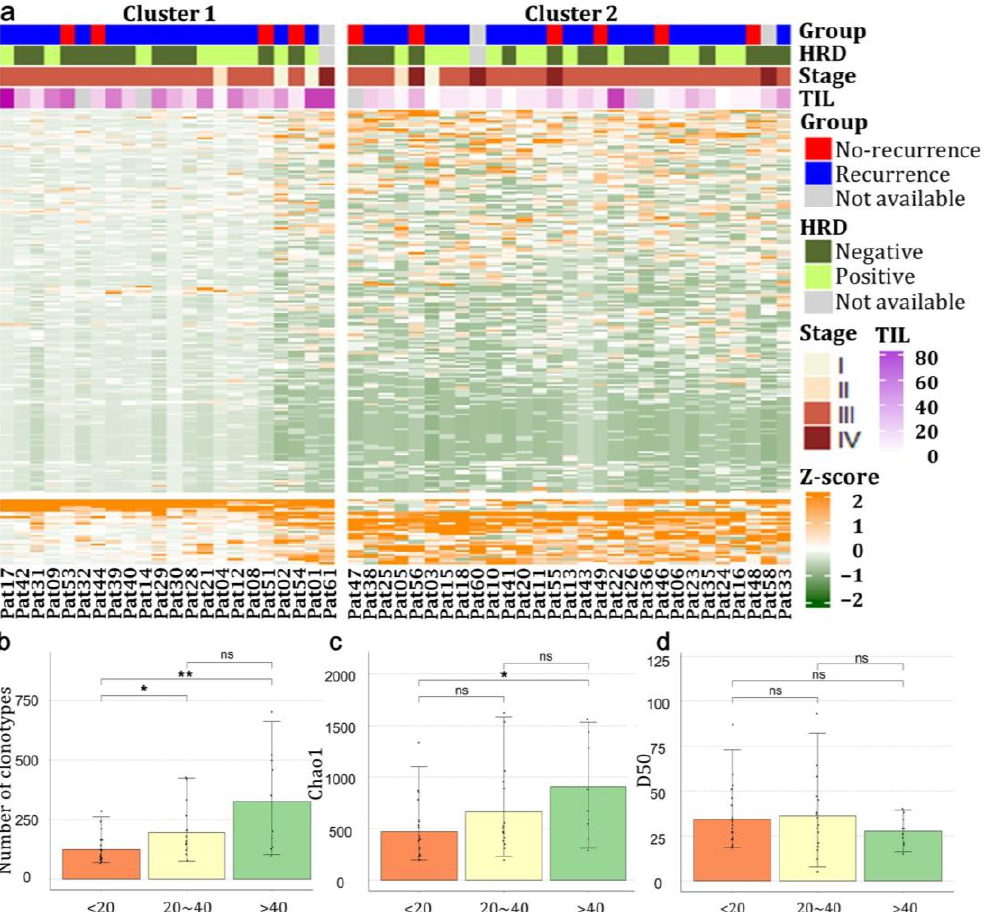
Figure 1. Distribution of T-cell receptor counts was associated with TIL scores. ( a ) Expression of TCR segments was standardized in each patient (the column of the heatmap). Recurrence, HRD mutation, stage, and TIL scores were annotated for each patient; ( b ) The counts of unique TCR clonotypes; ( c , d ) The richness and diversity of TCRs were estimated using Chao1 and the D50 diversity index, respectively, in patients divided based on their TIL percentage (%) scores. ( b – d ) Non- significant p -values are indicated as ns, significant p -values < 0.05 are indicated as *, and significant p -values < 0.01 are indicated as ** .